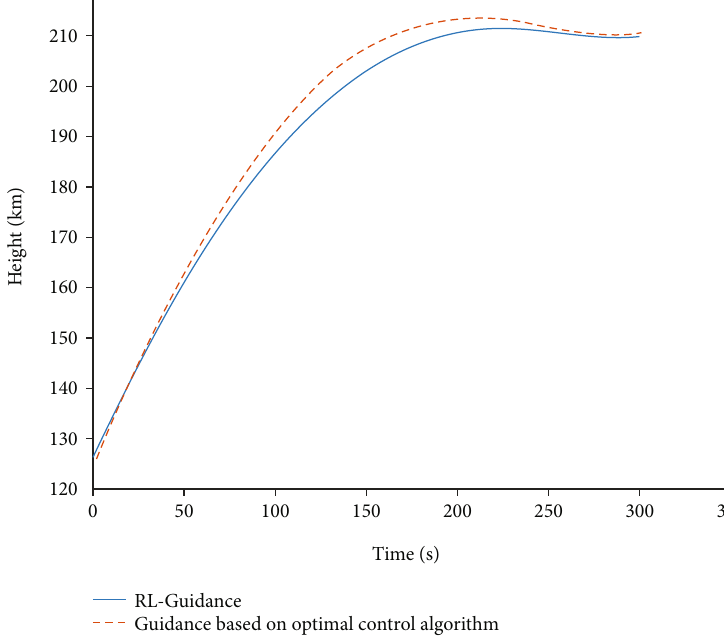
Figure 8: Height comparison of RL-guidance and guidance-based optimal